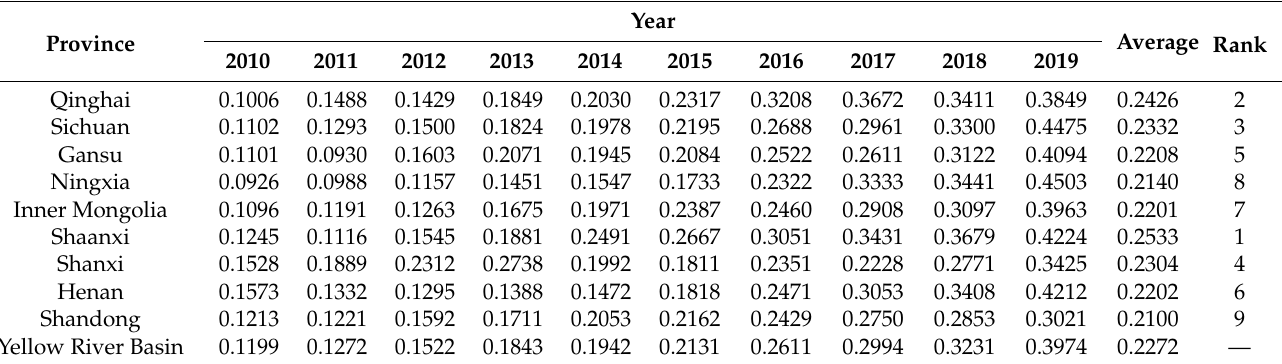
Table 5. Comprehensive evaluation of the tourism economy’s high-quality development (TEHQD) of the nine provinces in the Yellow River